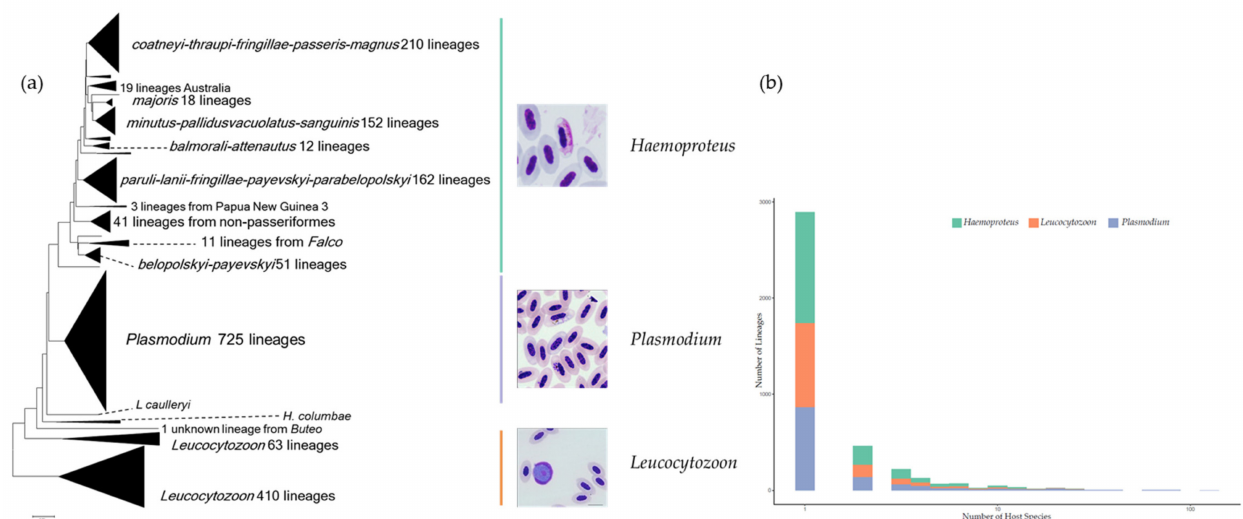
Figure 1. Phylogenetic pattern ( a ) and host diversity ( b ) of avian haemosporidian lineages. Data extracted from MalAvi database Version 2.4.9 (http://130.235.244.92/Malavi/index.html; Accessed on 28 April 2021). Microscopic images pre- senting the detectable life stages of avian haemosporidian parasites—gametocytes for all three genera and merozoites for Plasmodium